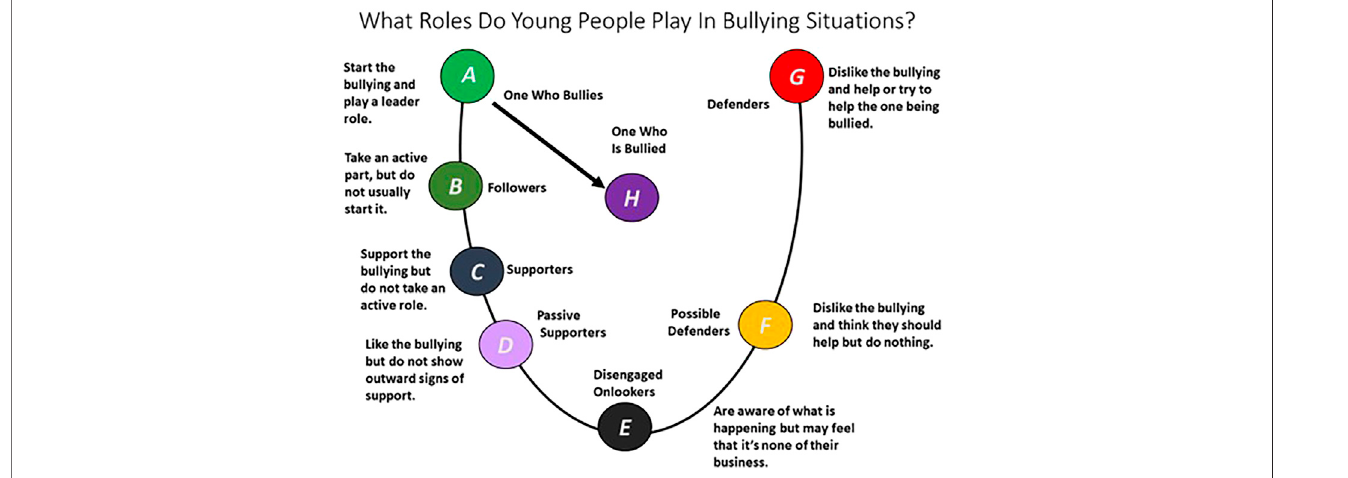
FIGURE 1 | Olweus Bullying Circle (Reprinted with permission from Safe and Humane School, Clemson University).